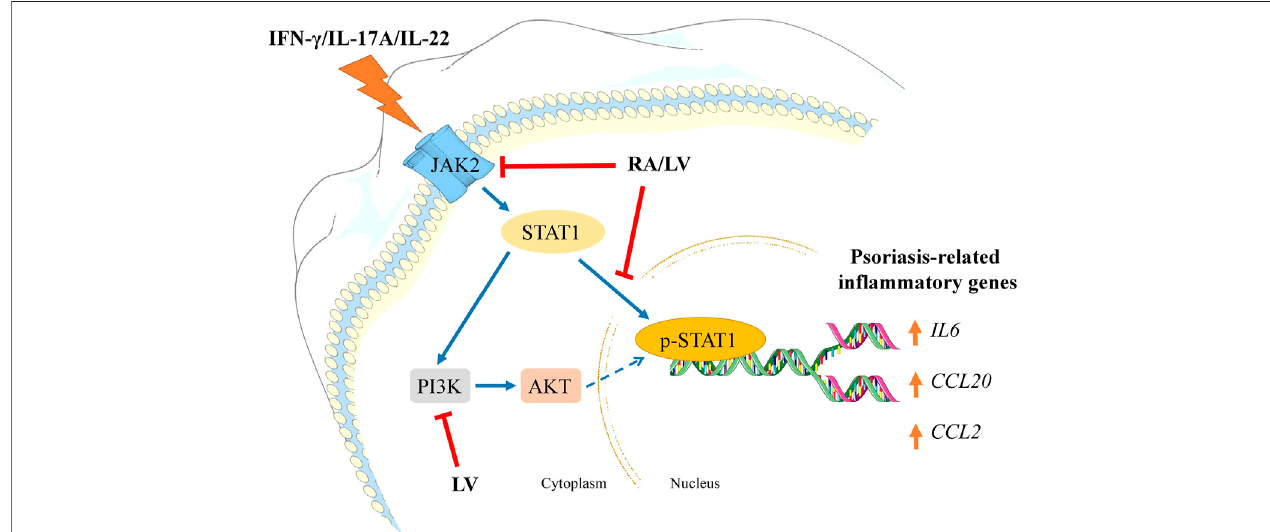
FIGURE 4 | Schematic representation of the proposed mechanisms of action of Lavandula angustifolia extract (LV) and rosmarinic acid (RA) in psoriasis-like in fl ammation model in human keratinocytes. HaCaT cells exposed to IFN- γ /IL-17A/IL-22 respond with activation of JAK2/STAT1 and PI3K/AKT signaling pathways. Activation ofJAK2 upon cytokine stimulation leads to STAT1 activation and its subsequent phosphorylation. Following nuclear translocation the phosphorylated STAT1 induces transcriptional activation of psoriasis-related in fl ammatory genes ( e.g., IL6 , CCL20 , CCL2 ). Activated PI3K/AKT axis in psoriatic keratinocytes correlates with induction of hyperproliferation and aggravation of the in fl ammatory milieu. In the present investigation, both RA and LV inhibited JAK2 and diminished STAT1 phosphorylation,hence, preventingin fl ammatoryactivation.Additionally,theLVextractdisruptedPI3K/AKTsignalingwhichcouldcontributetodecrease inproliferation rate in activated keratinocytes. Taken together, the obtained data suggest that LV and RA possess inhibitory effect on psoriasis-related in fl ammation in human keratinocytes.